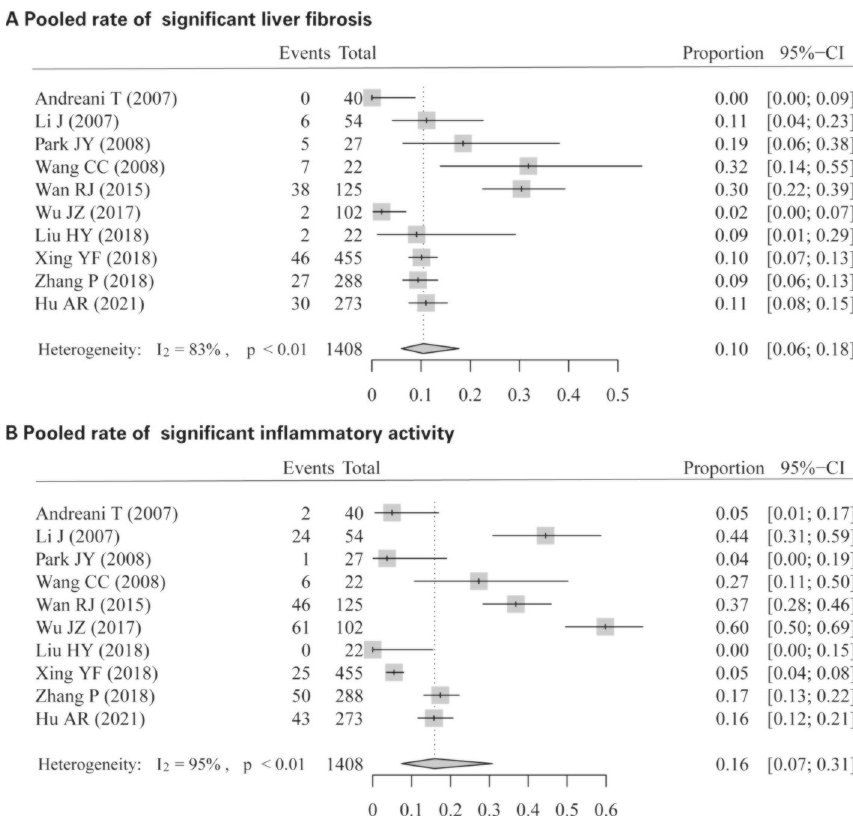
Figure 2. Pooled rate of significant histologic changes (significant liver fibrosis and inflammatory